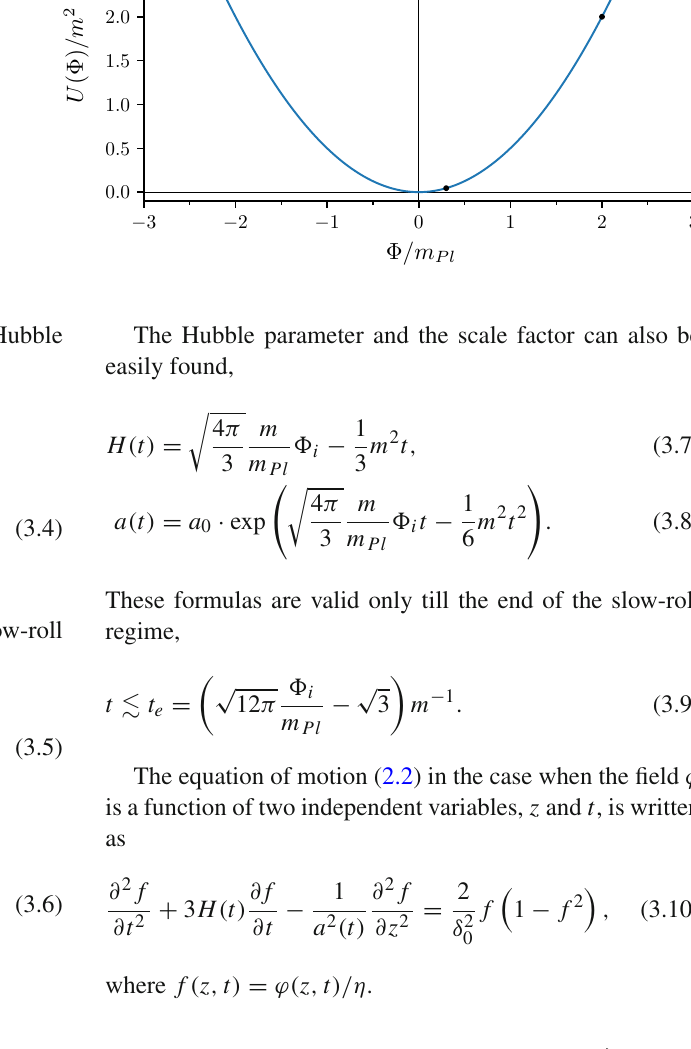
Fig. 2 Inflaton potential U